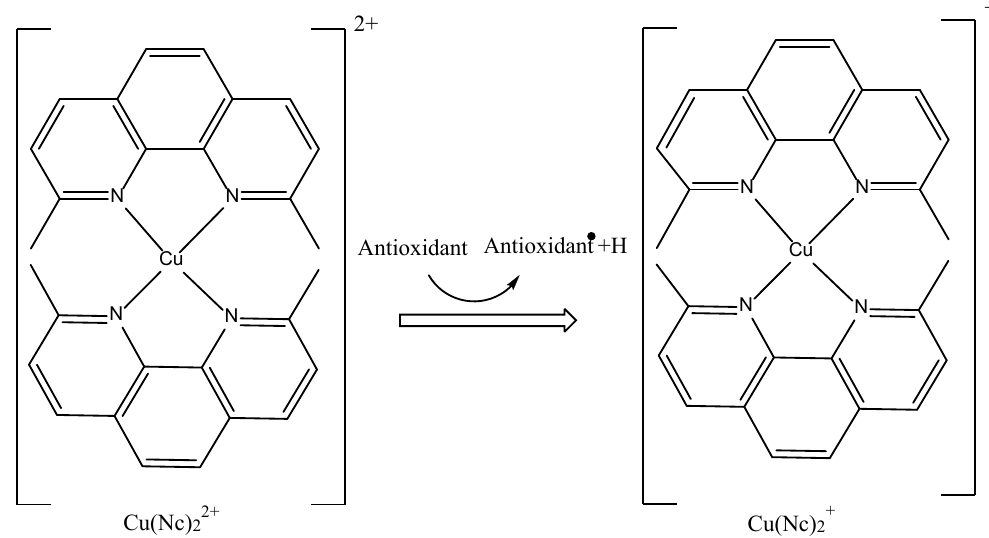
Figure 10. Proposed CUPRAC general reaction mechanism [23,26,46].